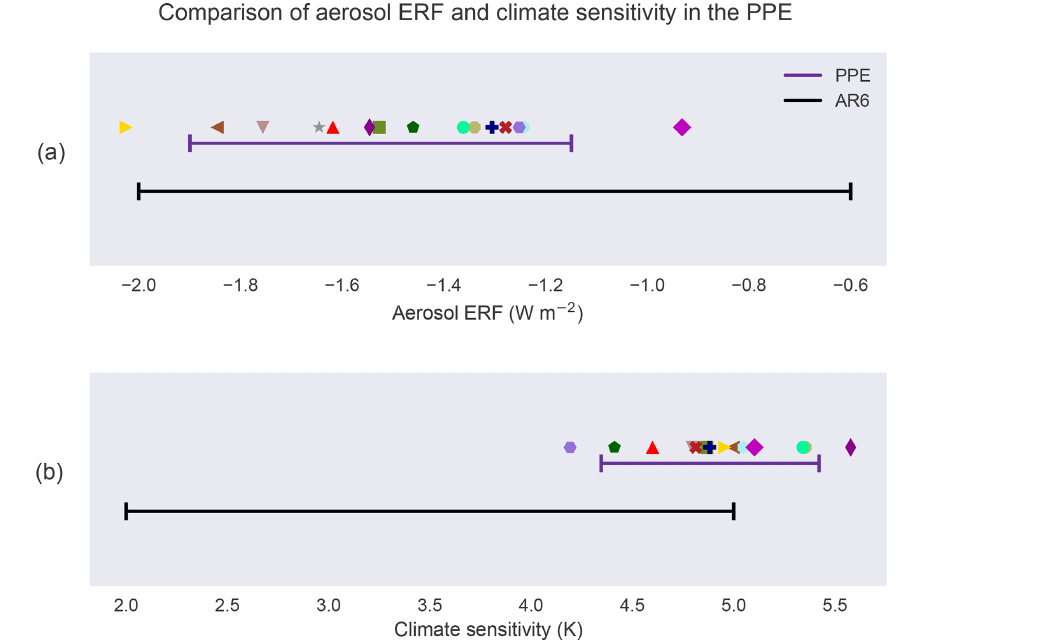
Figure 1. Range of aerosol ERF (a) and equilibrium climate sensitivity (b) across the PPE and AR6. The PPE error bars show the 90% range across 15 PPE members compared with the AR6 90% “very likely” ranges from Forster et al. (2021). We use 13 PPE members in this study, excluding two shown in this figure due to model